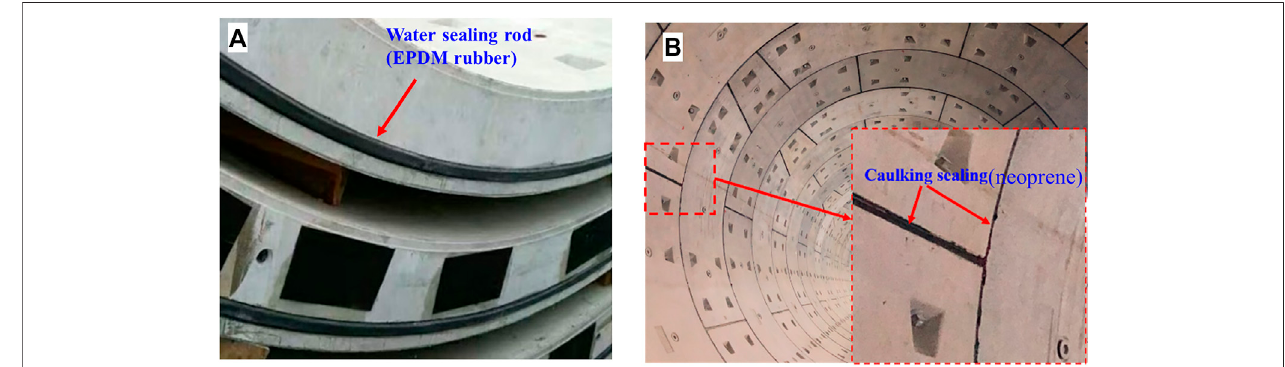
FIGURE 13 | (A) Common water sealing rod on the segment; (B) Caulking sealing by fl exible polyurethane sealant.